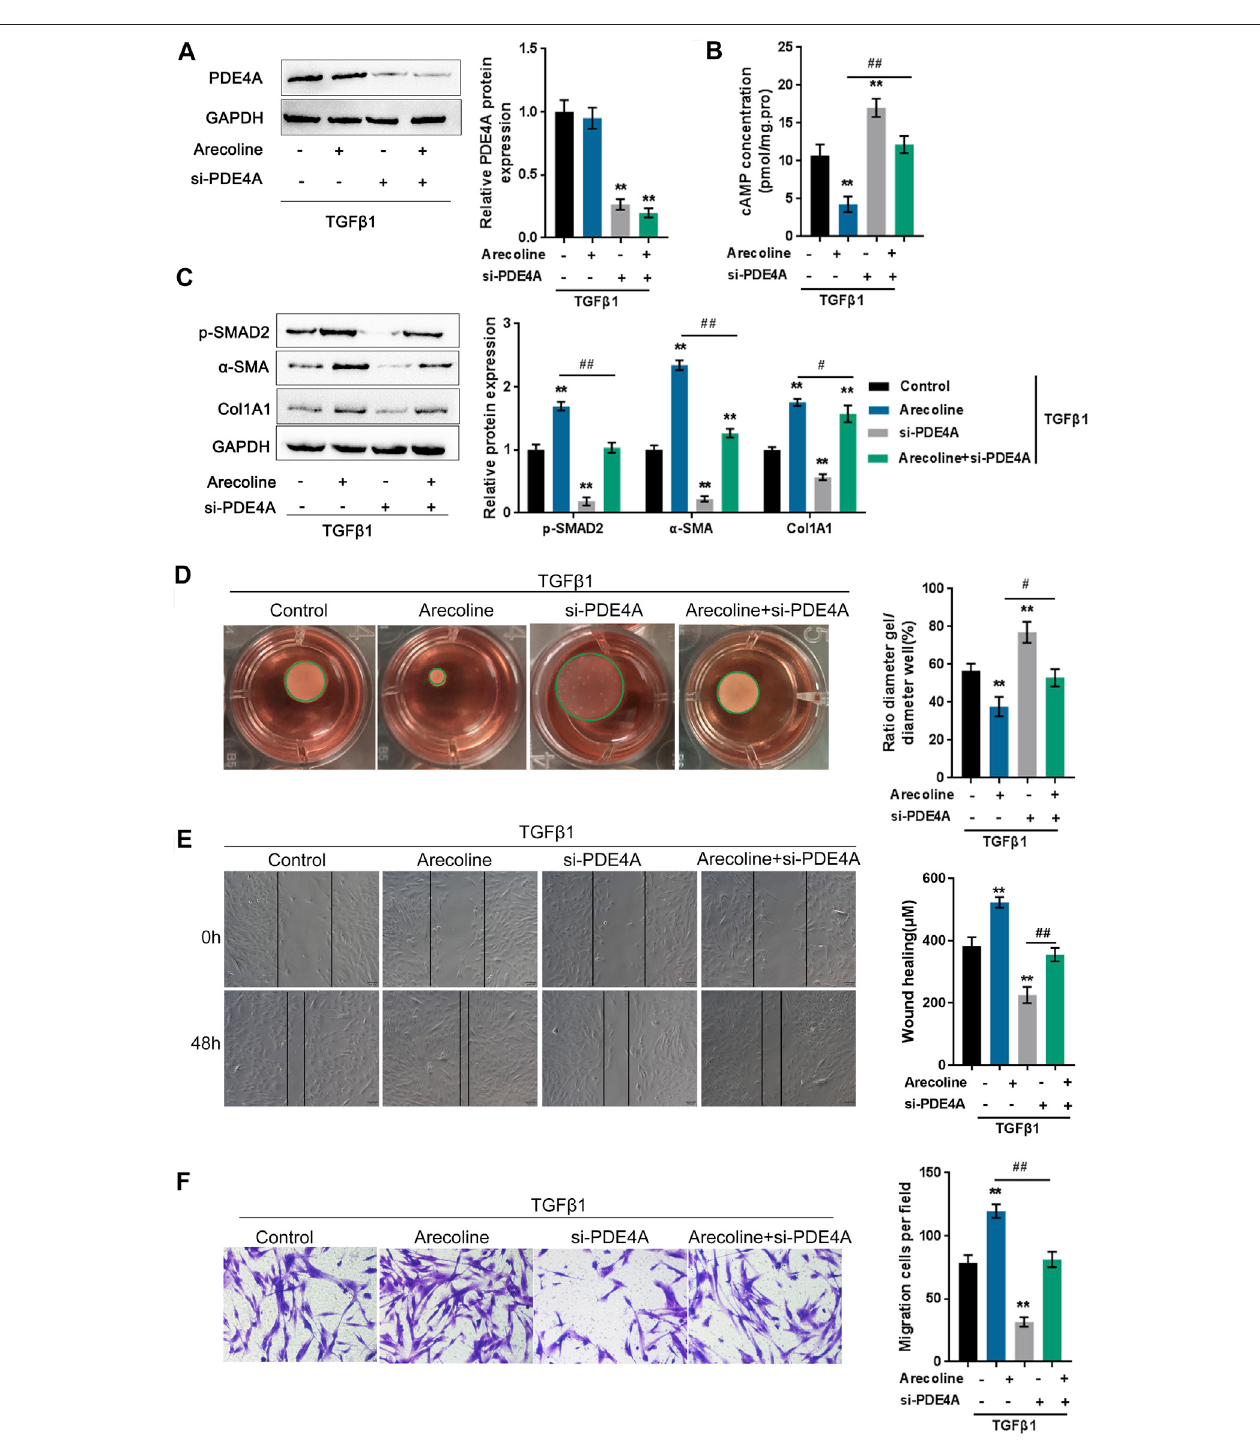
FIGURE 3 | Arecoline enhances TGF- β 1-induced BMFs activation. BMFs were transfected with si-PDE4A in the presence or absence of 50 µg/ml arecoline treatment upon 5 ng/ml TGF- β 1 stimulation for 48 h, and then examined for (A) the protein levels of PDE4A by Immunoblotting, n (cid:1) 3. (B) the cAMP concentration by ELISA, n (cid:1) 3. (C) the protein levels of p-Smad2, α -SMA, and Col1A1 by Immunoblotting, n (cid:1) 3. (D) the gel contraction capacity, n (cid:1) 3. (E,F) the migration capacity by Wound healing and Transwell assays, n (cid:1) 3. ** p < 0.01, compared to control group; # p < 0.05, ## p < 0.01, compared to arecoline group. ANOVA followed by Tukey post-hoc